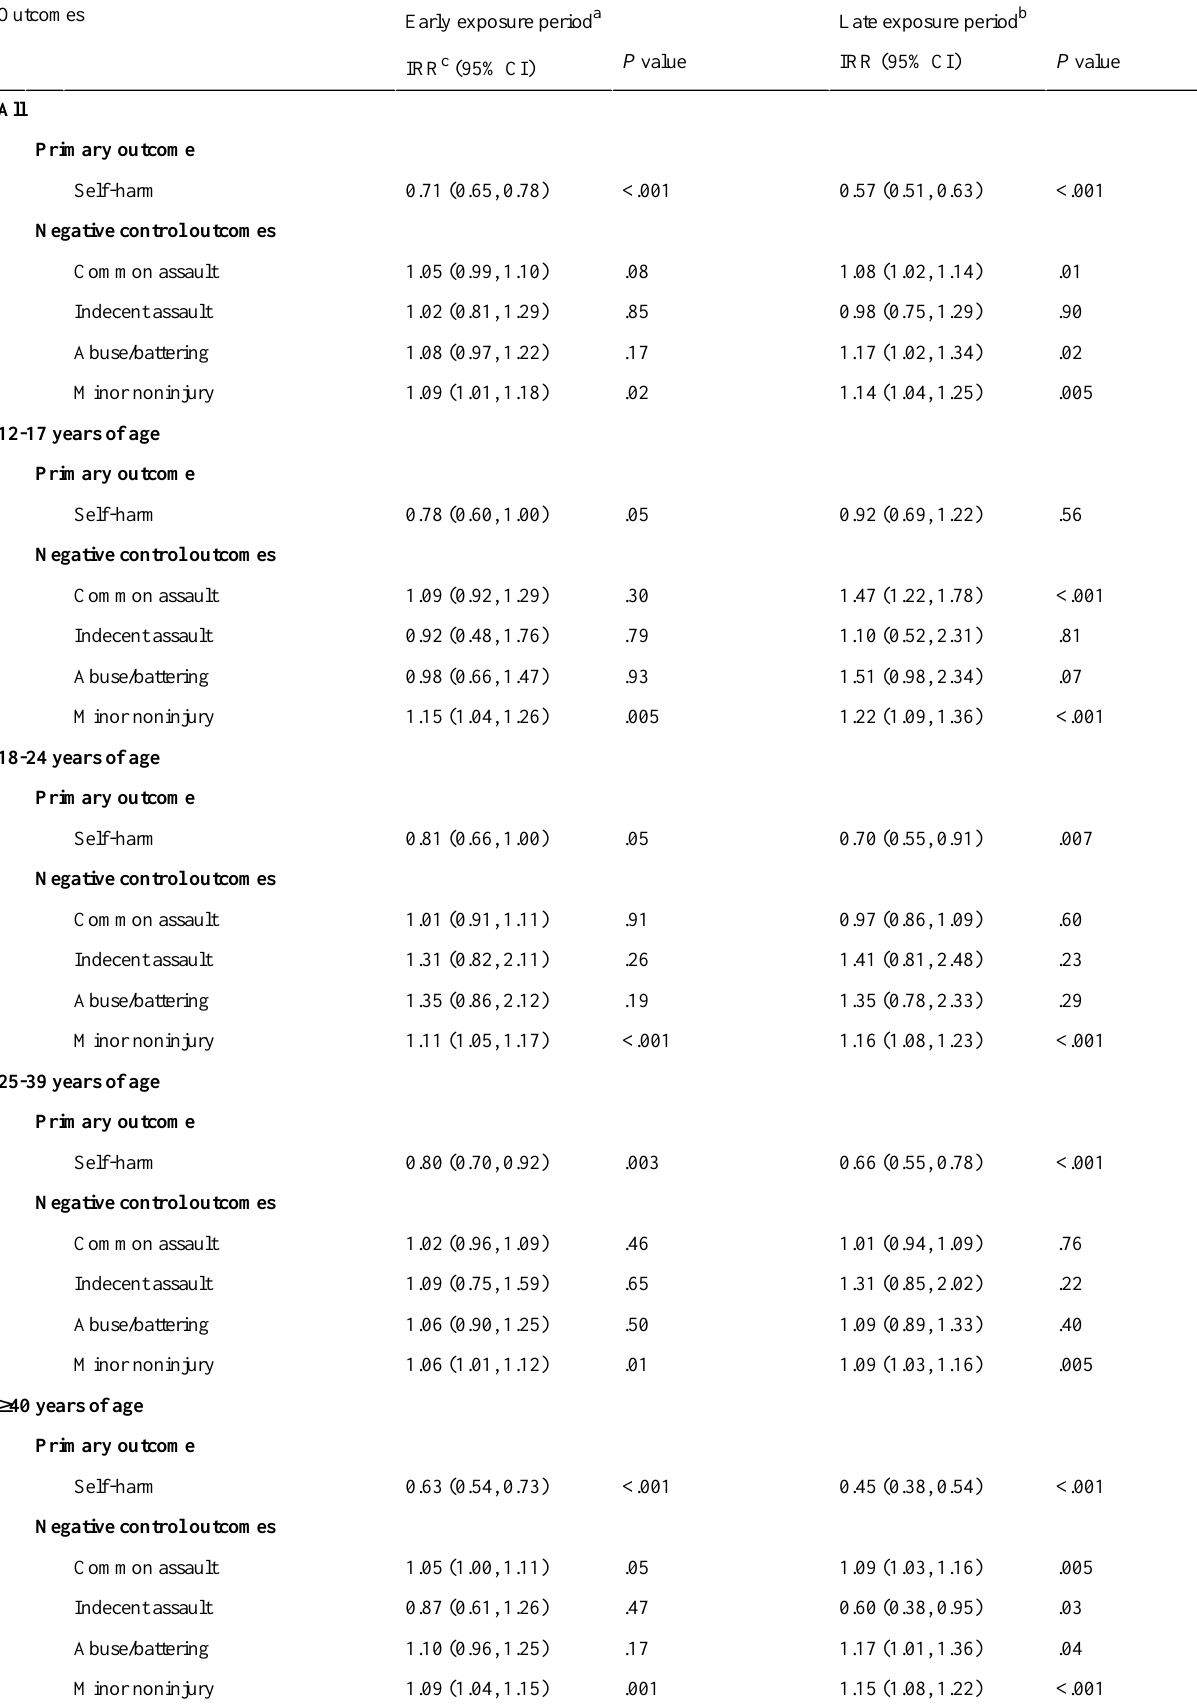
Table 3. Association between accident and emergency attendance and early and late periods after the launch of Pokémon Go from robust Poisson regression with adjustments for time trends, seasonal trends, age, gender, and population